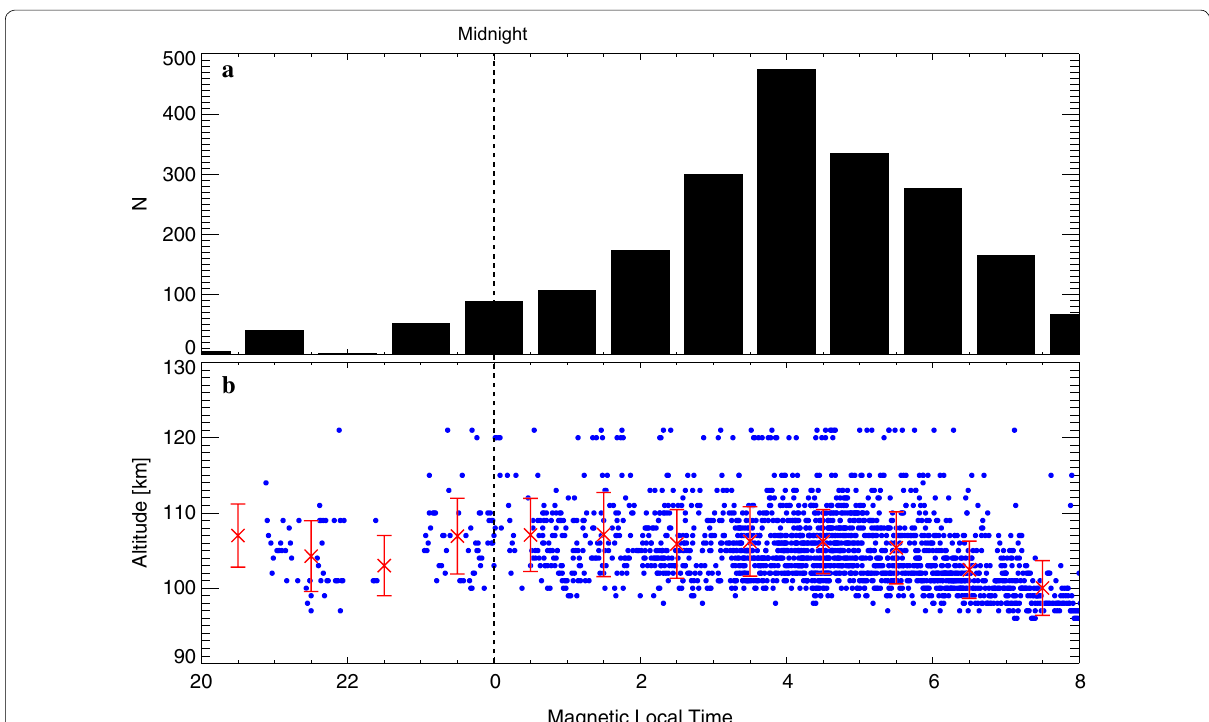
Fig. 5 a MLT distribution of intervals of pulsating aurora sampled from 37 nights of observations. b Dependence of the altitude of pulsating aurora on magnetic local time. The red cross marks and vertical bars respectively indicate the average and standard deviation of the altitude of pulsating aurora calculated every 1‑h magnetic local time